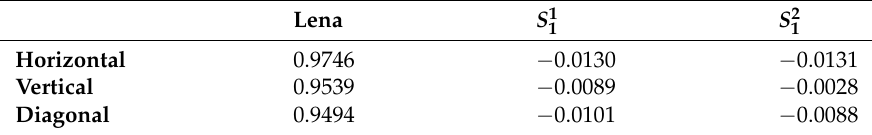
Table 1. The average correlation coefficients of shadows in (( 1,4 ) ,4,4,8 ) -PESIS